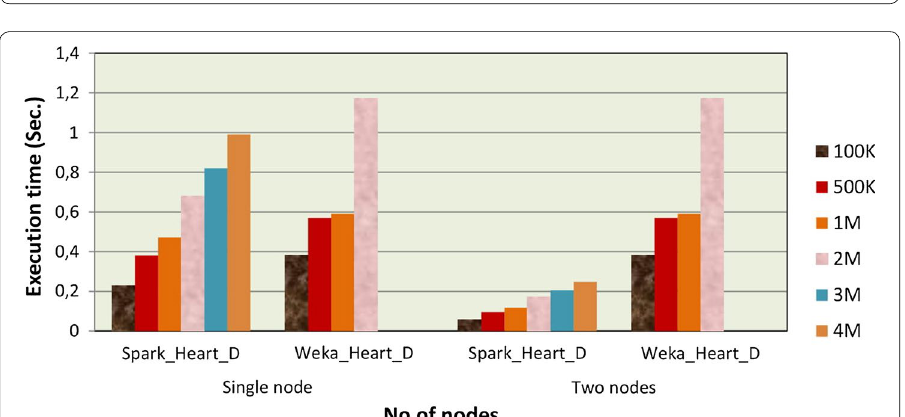
Fig. 13 Performance comparison of DT using Spark and Weka for different nodes: time taken to build model. K: thousand, M: Million